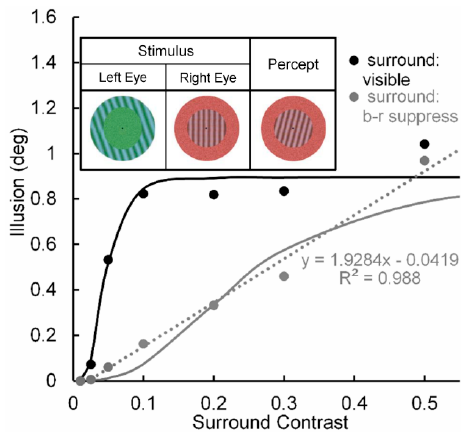
Figure 3. Tilt illusion (in deg) as a function of linearized surround-inducer contrast when the tilted surround is visible (black circles) and when it is b-r suppressed (grey circles). Continuous lines are best fitting Naka-Rushton functions; dotted line is best fitting linear function to the contrast-dependent tilt illusion when the surround is b-r suppressed. Upper inset: Pearson & Gifford’s stimuli presented to observers’ left and right eyes under dichoptic viewing, giving rise to b-r suppression of the left-eye annular grating surround by a right-eye annular noise mask, and the resultant binocularly fused percept. Adapted from [51] with permission from the publisher.